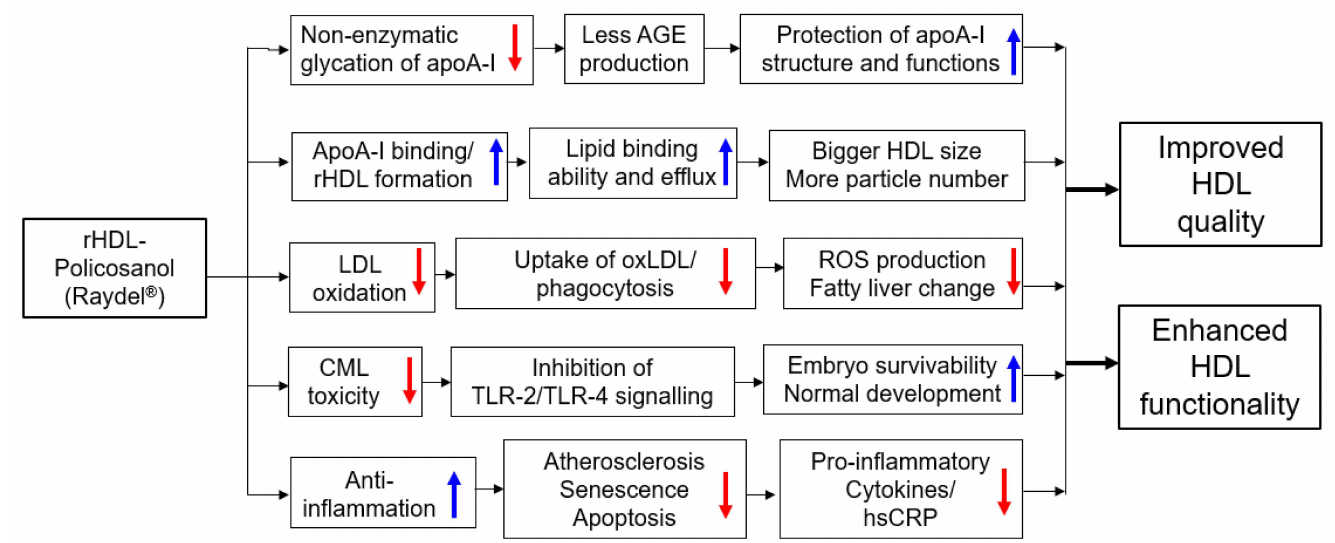
Figure 7. Proposed mechanism of rHDL containing policosanol (Raydel ® ) for enhancement of HDL quality and functionality via inhibition of glycation of apoA-I and oxidation of LDL. AGE, advanced glycated end product; CML, carboxymethyllysine; hsCRP, high-sensitive C-reactive protein; HDL, high-density lipoproteins; LDL, low-density lipoproteins; rHDL, reconstituted HDL; ROS, reactive oxygen species; TLR, toll-like